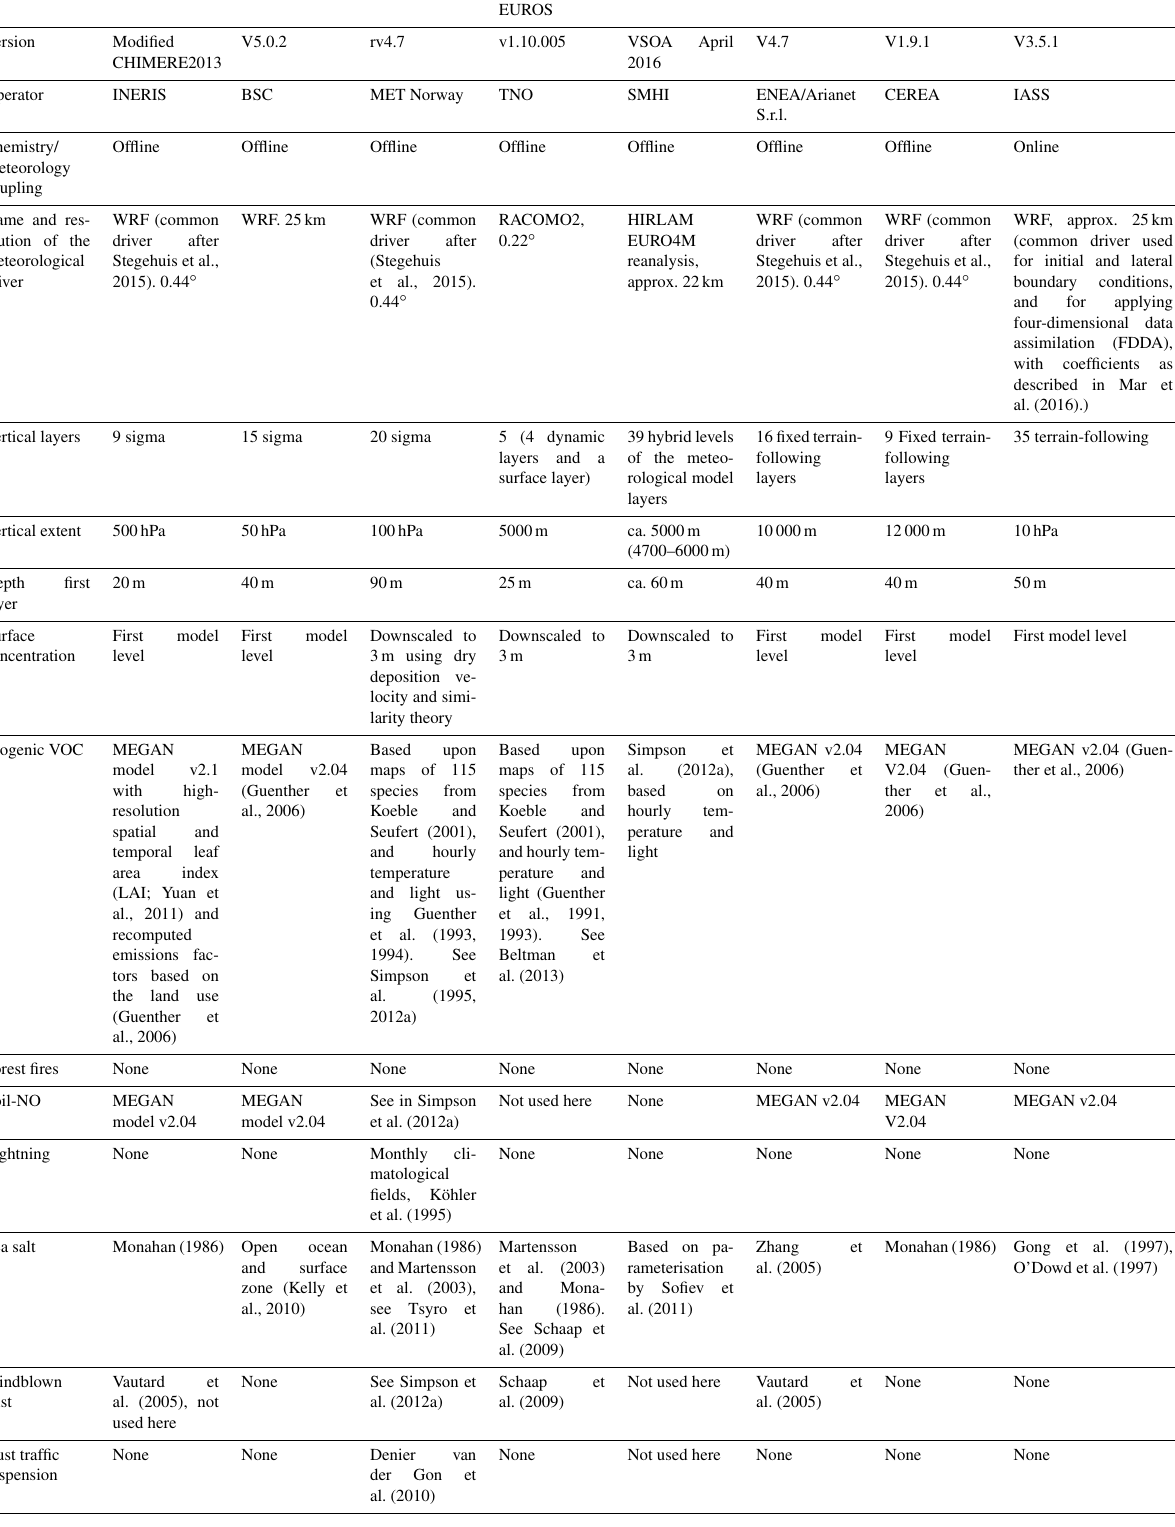
Table 1. Main features of the chemistry-transport models involved in the EURODELTA-Trends modelling exercise.